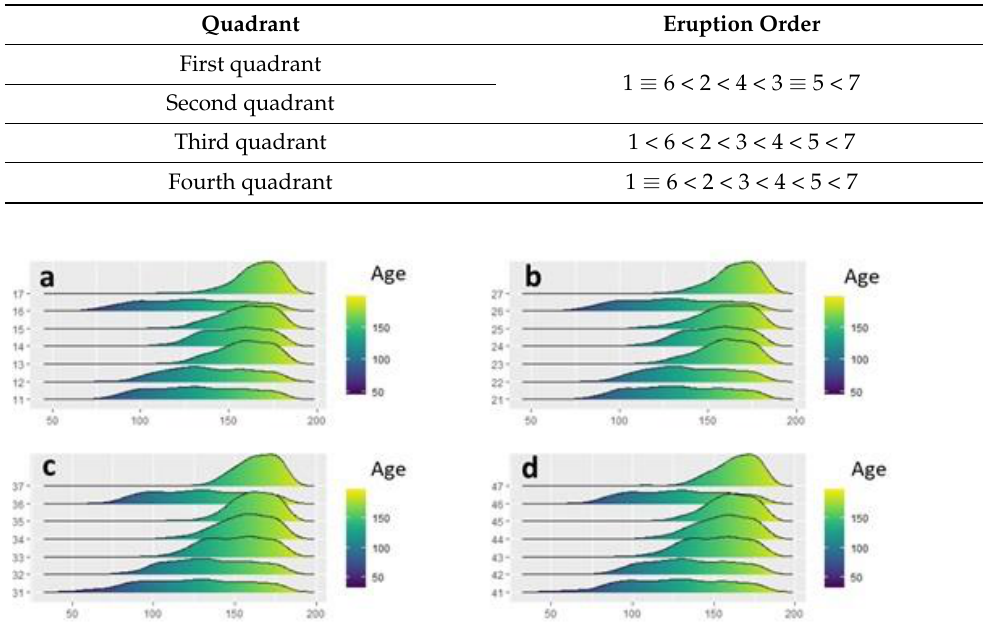
Figure 6. Estimation of the density of the age of the individuals having each tooth by quadrant: first quadrant ( a ), second quadrant ( b ), third quadrant ( c ), fourth quadrant ( d ).